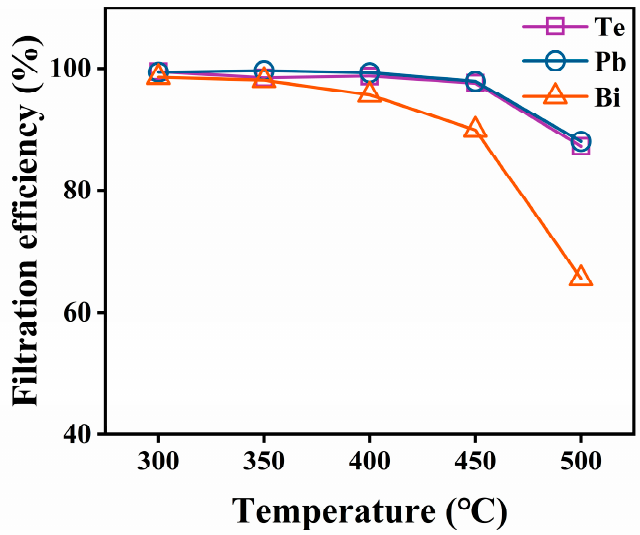
Figure 4. Obtained deposition masses of Te, Pb, and Bi from filters SNF1–SNF5 on ( a ) SiO 2 nanofiber membrane and ( b ) stainless-steel mesh at different temperatures.